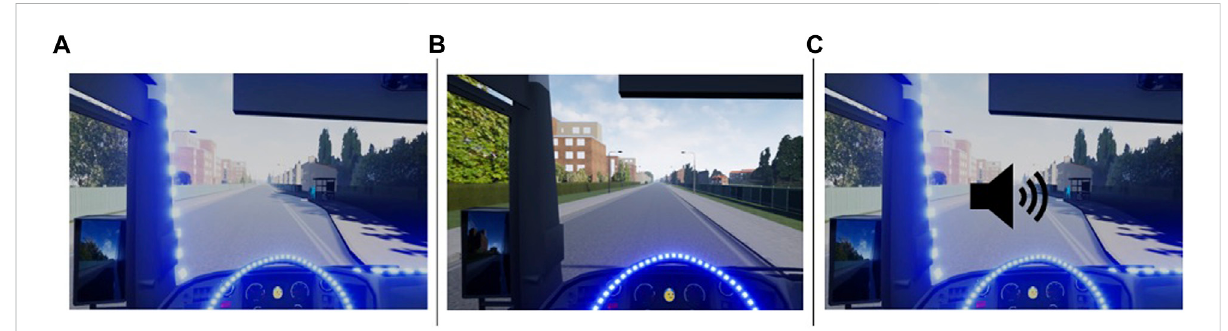
FIGURE 18 ThreeeHMIconditionsviewedfromtheinsideofthebus:steeringwheelandwindshield (A) ;steeringwheelonly (B) ;steeringwheel,windshield, and sound cue (C) .